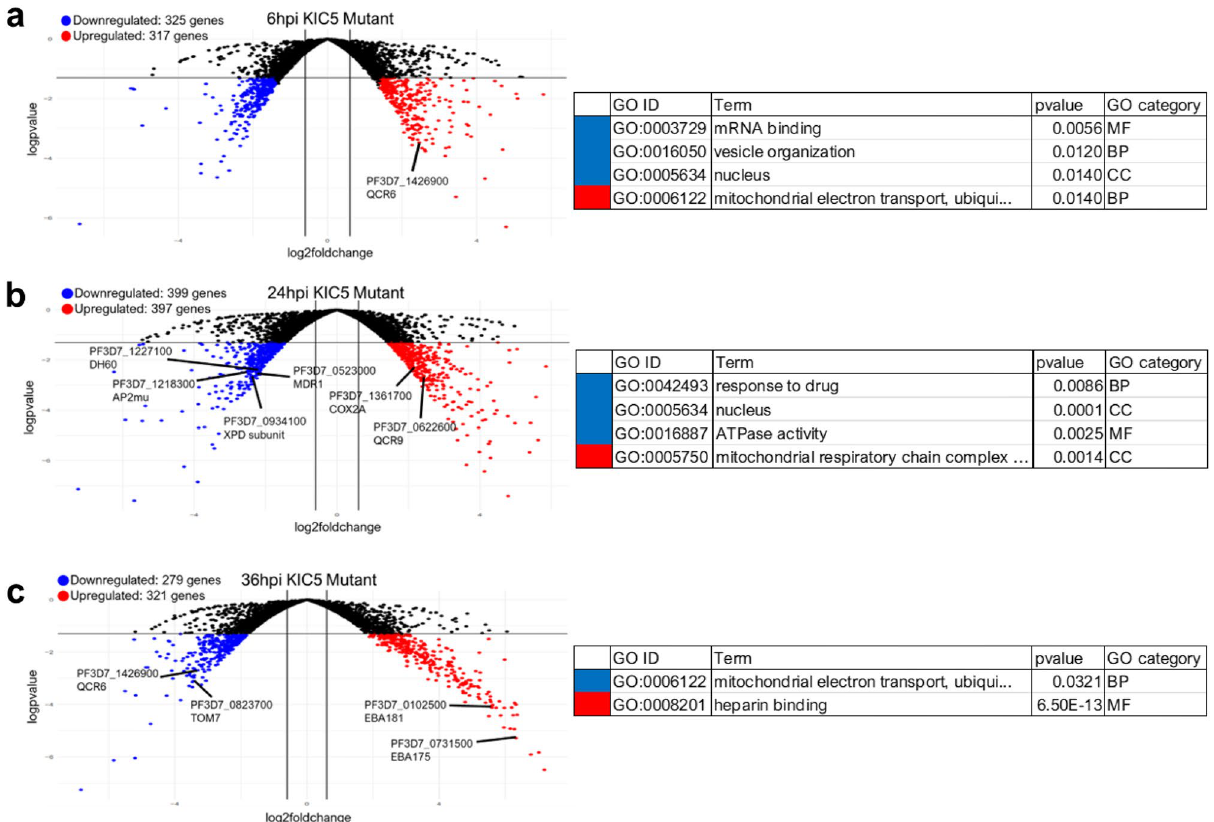
Figure 3. Differentially expressed genes and gene ontologies in the KIC5 mutant at 6 hpi, 24 hpi, and 36 hpi. Volcano plots showing differential gene expression at ( a ) 6 hpi [downregulated: 325 genes, upregulated: 317 genes], ( b ) 24 hpi [downregulated: 399 genes, upregulated: 397 genes], and ( c ) 36 hpi [downregulated: 279 genes, upregulated: 321 genes] (Supplementary Table S4). Compared to 12 hpi and 48 hpi, there are an increased number of DE genes at these three chosen timepoints. For each timepoint shown, R package pfGO (v 1.1) was used to perform gene ontology enrichment. Select upregulated and downregulated gene ontologies related to GO cellular compartment (CC), GO molecular function (MF), or GO biological process (BP) are displayed (Supplementary Table S9). Blue: downregulated genes, red: upregulated genes. Results plotted with log2-fold change (KIC5 mutant/NF54 WT) vs log2 p-value. FDR corrected p-value < 0.05; log2-fold change upregulated > 1.4, downregulated < −